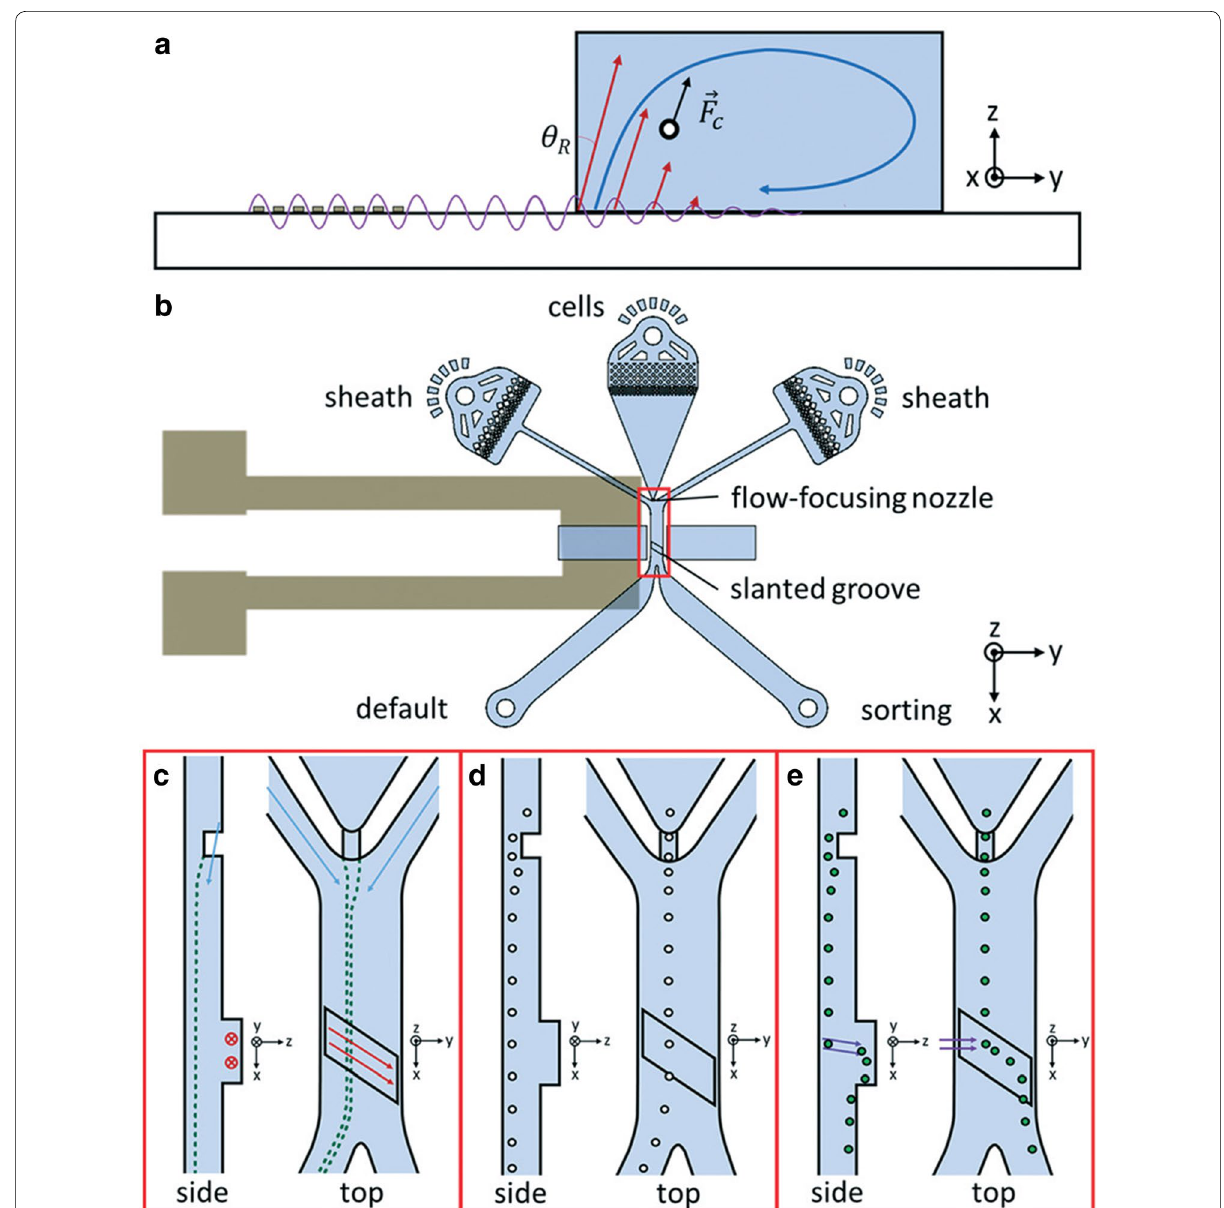
Fig. 3 A 3D microfluidic chip with integrated structures for particle sorting using surface acoustic waves. a Cross-section of the device. b Design of the device. c – e Mode of action (Adapted from Ung et al.